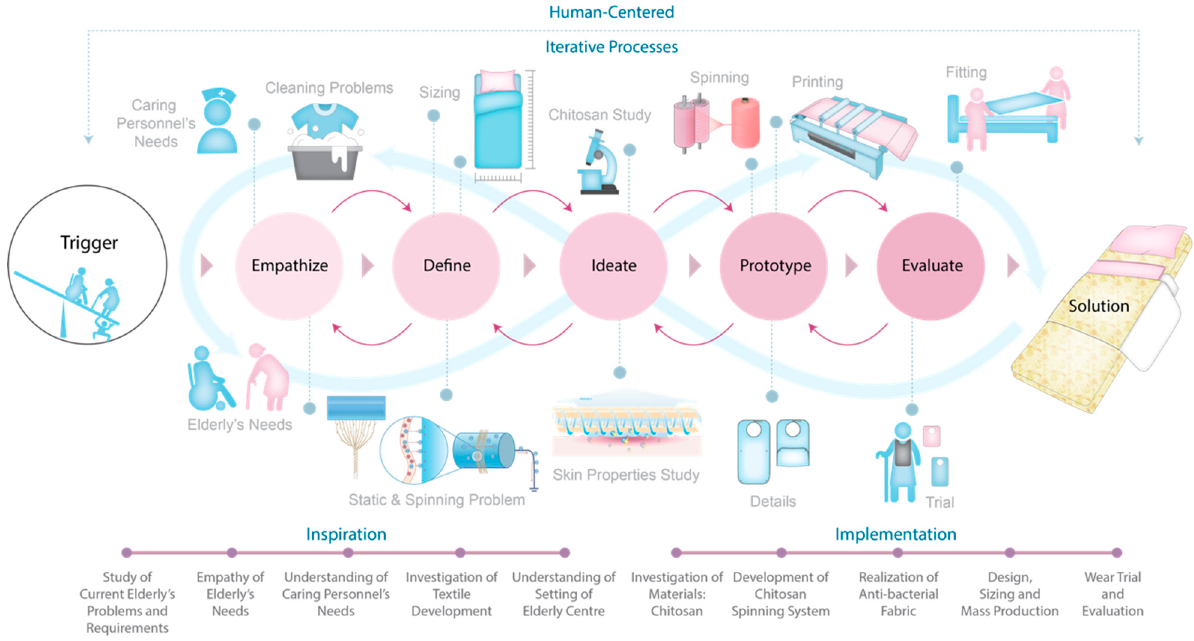
Figure 7. The design thinking processes.